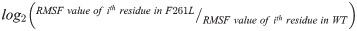
MD simulation analysis of the F261L and wild type CYP1B1 structures.Panel A shows a similar distribution of the first three major principal components of F261L and wild type (WT) CYP1B1 structures, suggesting relatively unchanged functional motions in the F261L mutant as compared to the WT structure. Panel B shows the altered flexibility pattern of the F261L mutant as compared to wild type. The log2ratio is calculated as log2(RMSF value of ith residue in F261LRMSF value of ith residue in WT). Therefore a positive value indicates an increase in flexibility in the F261L mutant and a negative value indicates a decrease in flexibility as compared to WT CYP1B1. F261L mutant has a significantly altered flexibility pattern within the C-D, F and G'-H block regions, shown separately in the right hand side of the panel. Panel C shows the altered tunnels in two different orientations (top and bottom view) of the F261L and WT CYP1B1 structures. The upper panel of "Tunnel properties" shows the radius (in bar plot) and length (in black line) of the tunnels (Top view orientation) in the mutant (orange) and WT (green) structures while the lower panel shows the similar properties of tunnels observed in the bottom view orientation. Panel D shows docked retinol in the WT and F261L mutant CYP1B1 structures. The panel also shows an overall increase in binding energy in F261L mutant retinol binding observed through MD simulation.